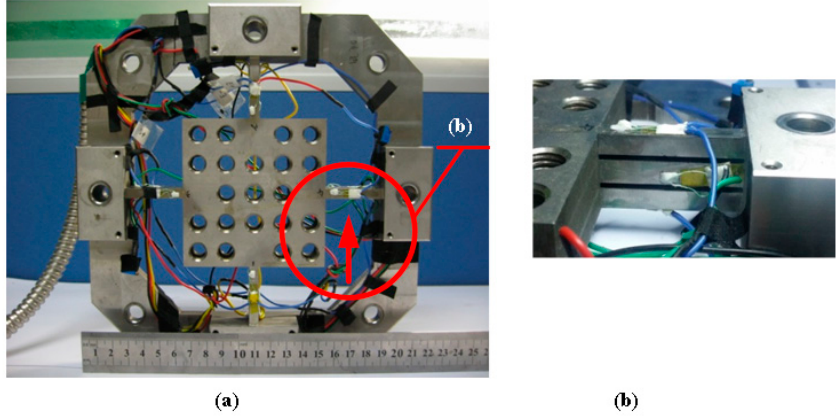
Figure 5. ( a ) Photograph of fabricated sensor; ( b ) the magnified front view of an elastic beam.